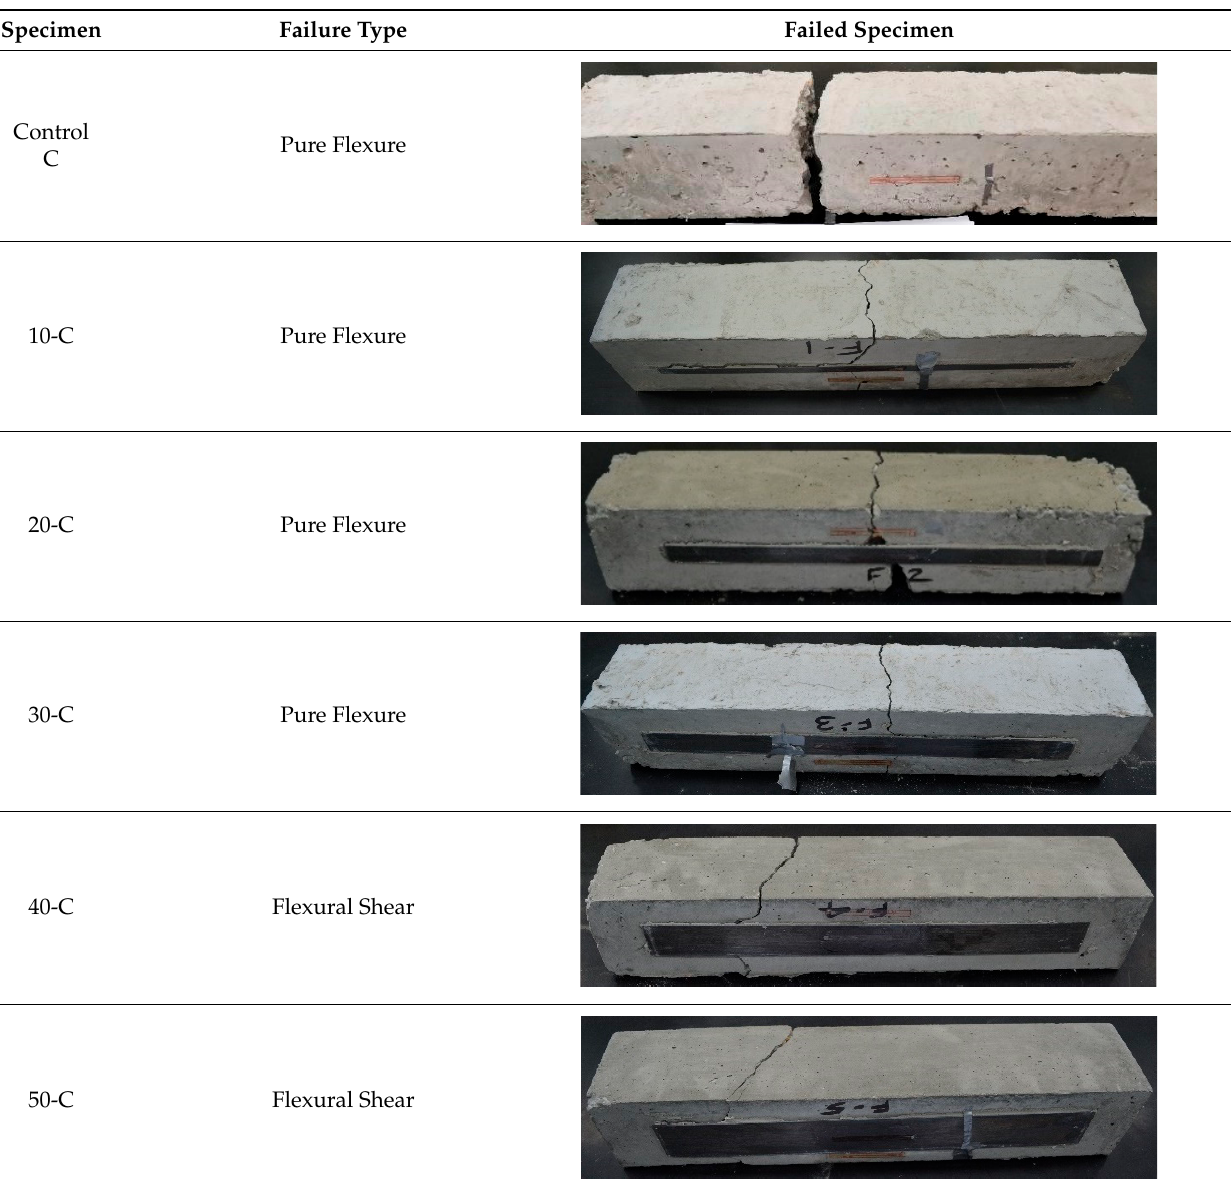
Table 8. Flexure and shear crack propagation of the tested beam samples.